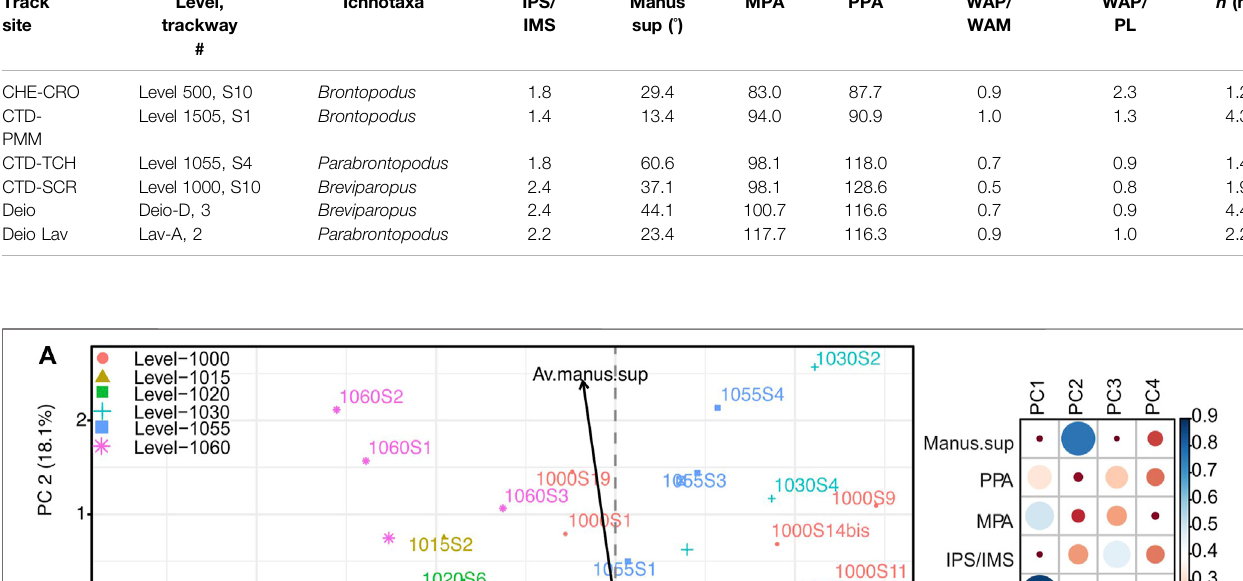
TABLE 2 | Ichnogenera for comparison with the TCH site. Data taken from Marty et al. (2010) with acronyms as per text. Track site